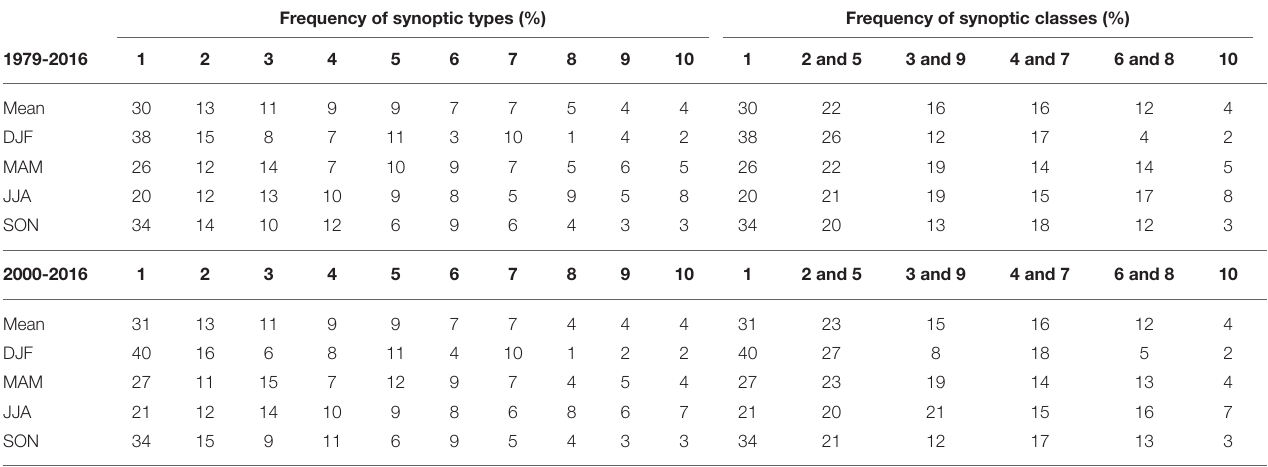
TABLE 6 | Frequency of synoptic weather types and classes ( % ) between 1979 and 2016 and 2000 and 2016. Frequency of synoptic types (%) Frequency of synoptic classes